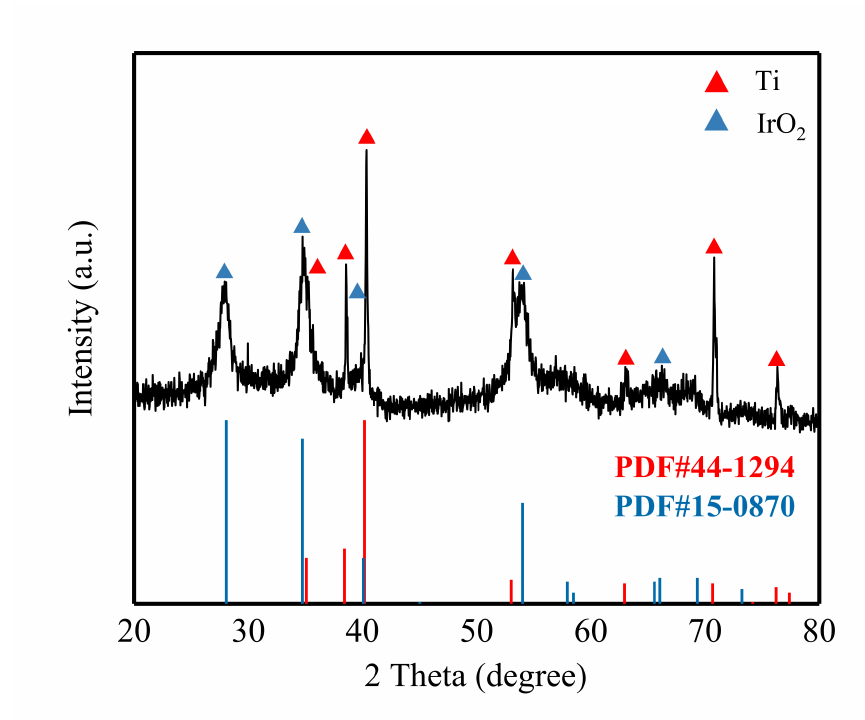
Figure 2. XRD pattern of the Ti/Ta 2 O 5 -IrO 2 electrode.